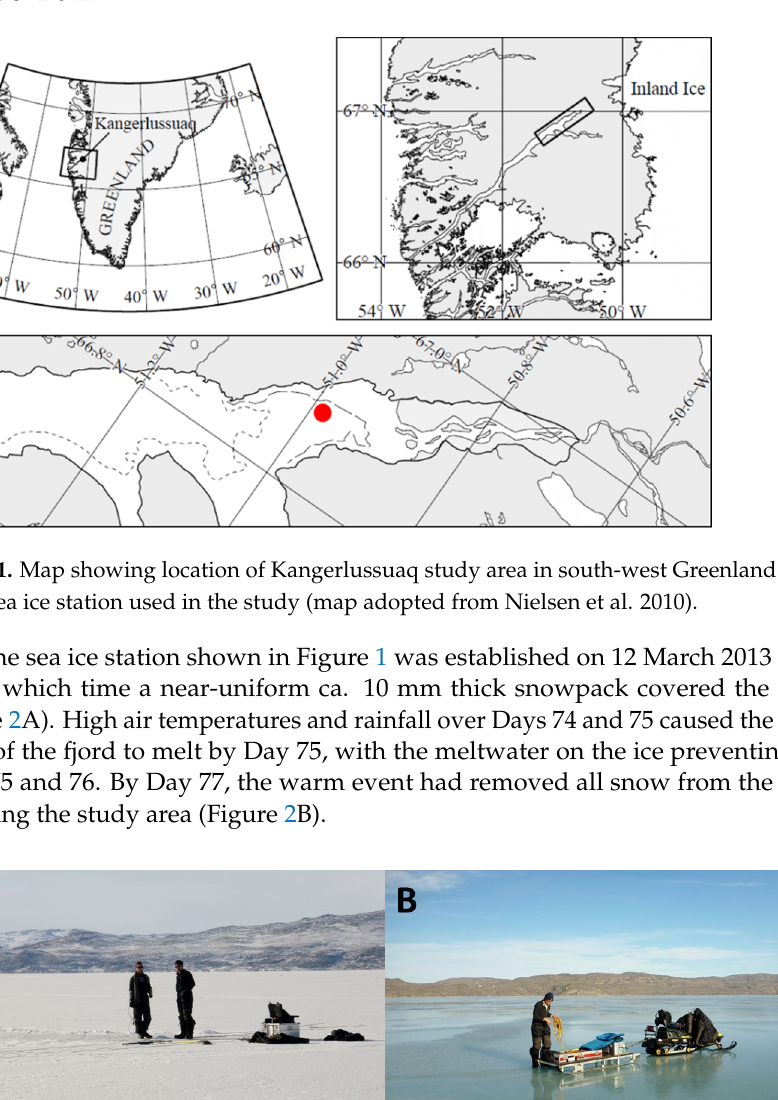
Figure 3. Time series at the sea ice station of ( A ) air temperature and ( B ) irradiance (photosyntheti- cally active radiation, PAR) at the ice surface (blue) and under-ice (red). The periods of cold, snow- covered ice, melting snow during the storm event, and post-snowmelt warm ice are shown in ( A ), with black arrows marking the sampling events (Days 71 and 73 with snow cover, Days 77 and 78